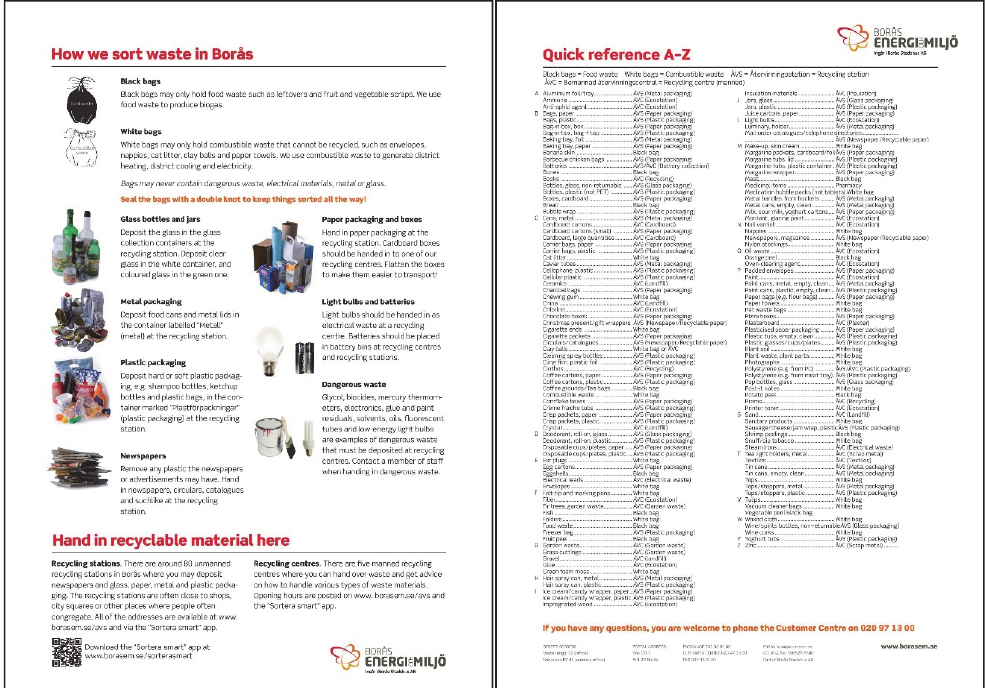
Figure A29. Front (left) and back (right) of the provided information sheet. This figure is also shown at <borasem.se/download/18.514ad6e915a834ad6bc69bff/1488532278694/Infoblad_sortering_foto_1601_eng.pdf> for the sake of legibility.